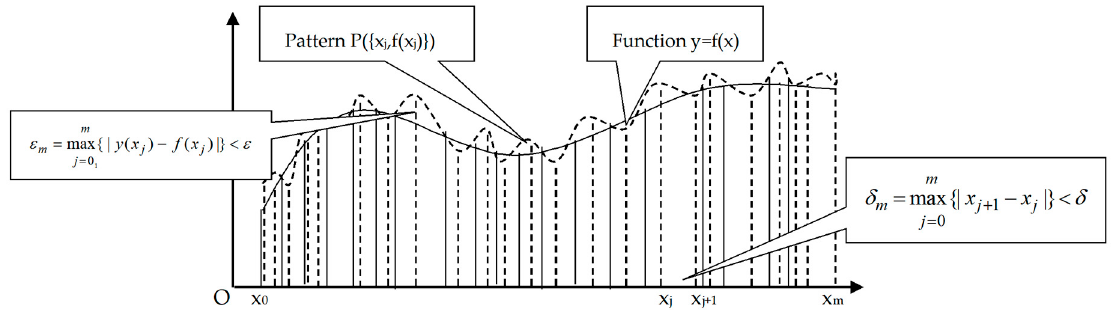
Figure 4. The competition between the pattern of compuing values of one variable function y = f(x) and graph of y = f(x).